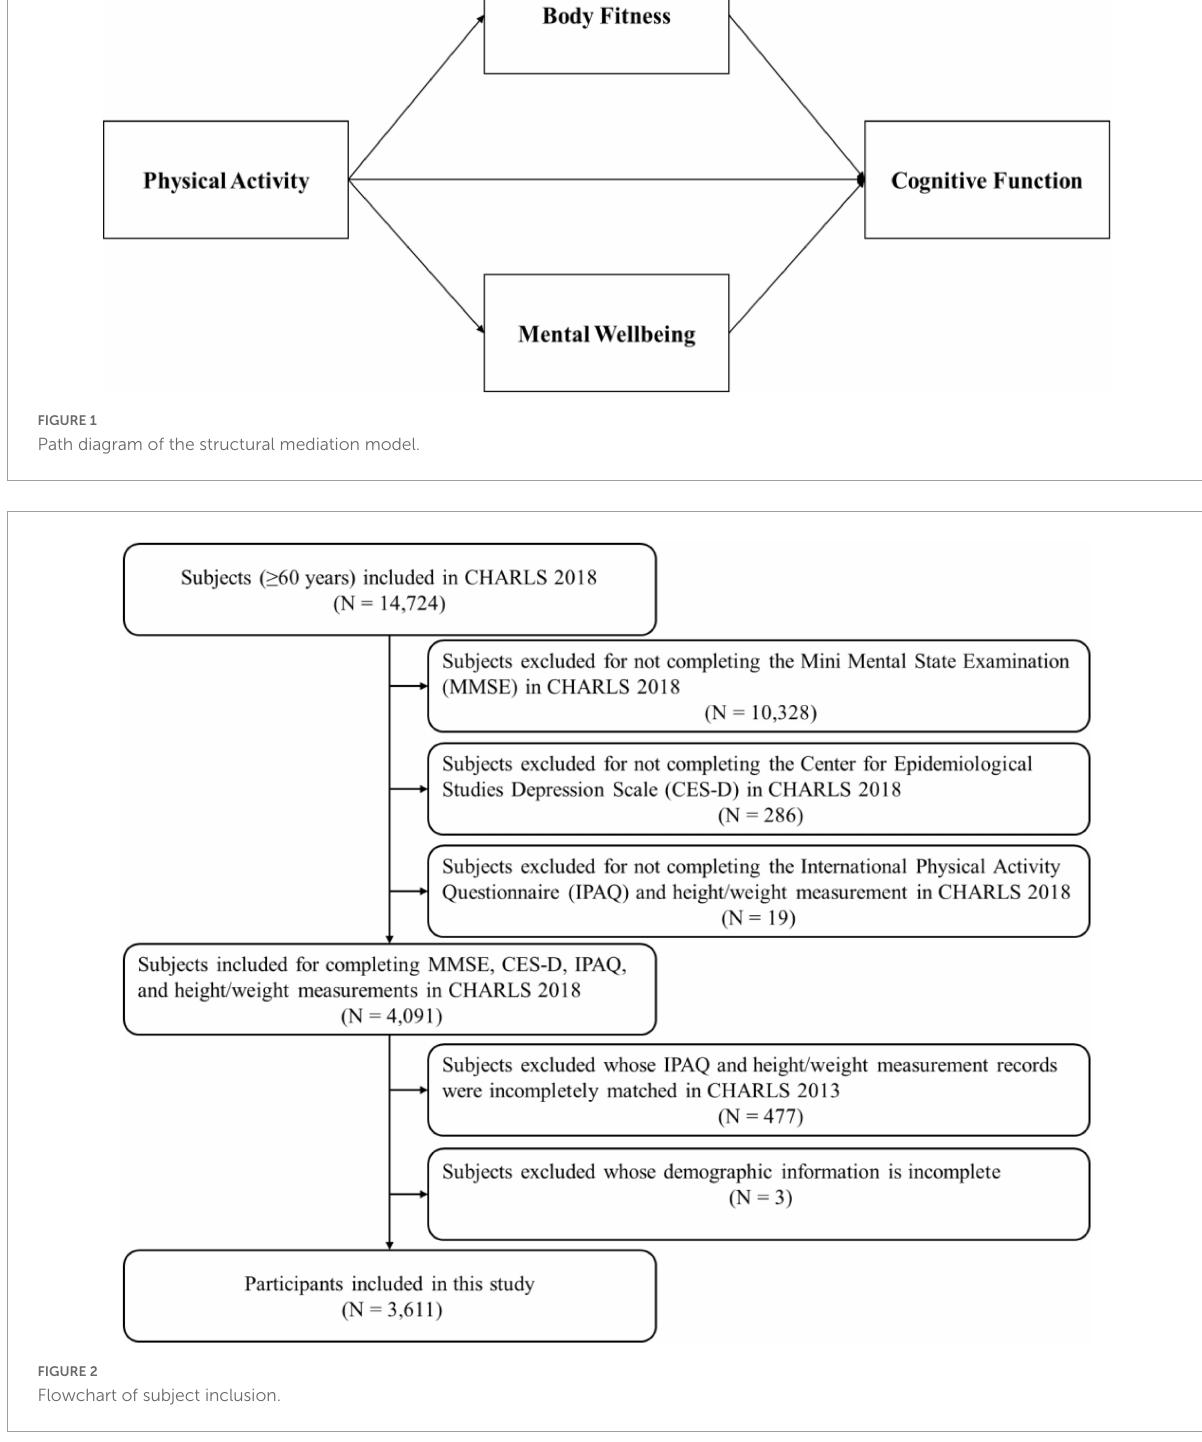
FIGURE2 Flowchart of subject